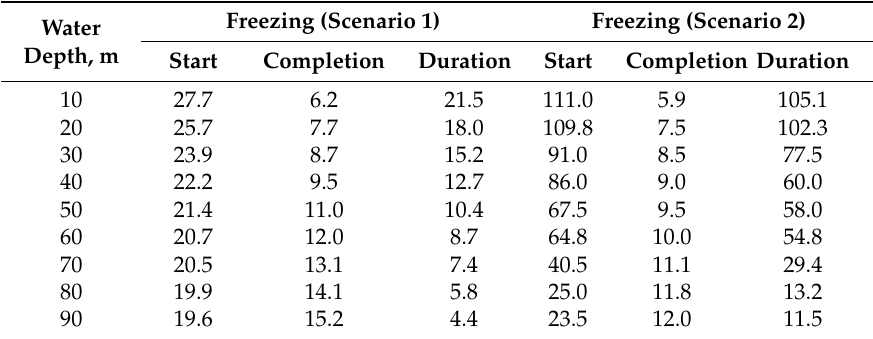
Table 1. Frost duration (kyr) for series of the model run